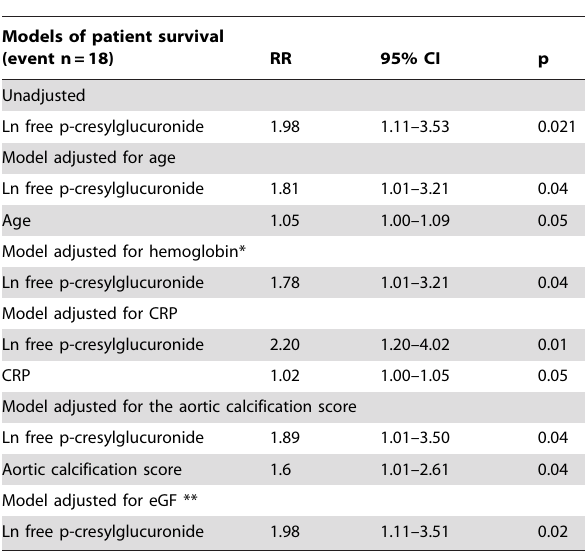
Table 6. Univariate and multivariate Cox regression analysis of risk factors at baseline for all-cause mortality, with free p- cresylglucuronide entered as a continuous variable in the predialysis population